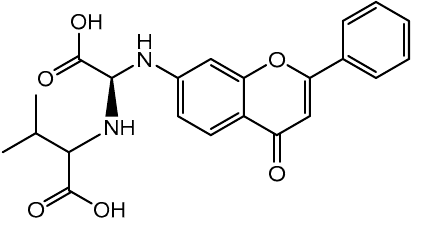
Figure 16. Chemical structure of flavone − dipeptide hybrid L-Val-OH ( 41 ).